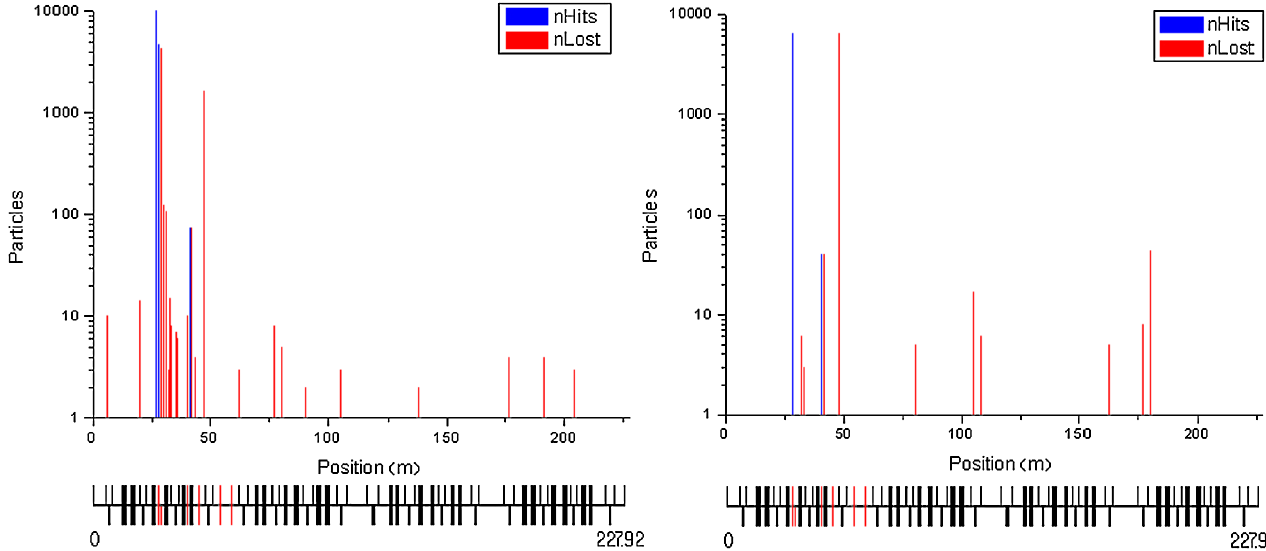
FIG. 7. Lost particles and the corresponding positions in the ring for an anticorrelated beam at 80 MeV. nHits denotes the number of particle hitting on the collimators and nLost denotes the number of absorbed particles. A total of 10 000 particles are injected. Left: (cid:1) ¼ (cid:1) 1 : 03% ; right: (cid:1) ¼ 1 : 03%